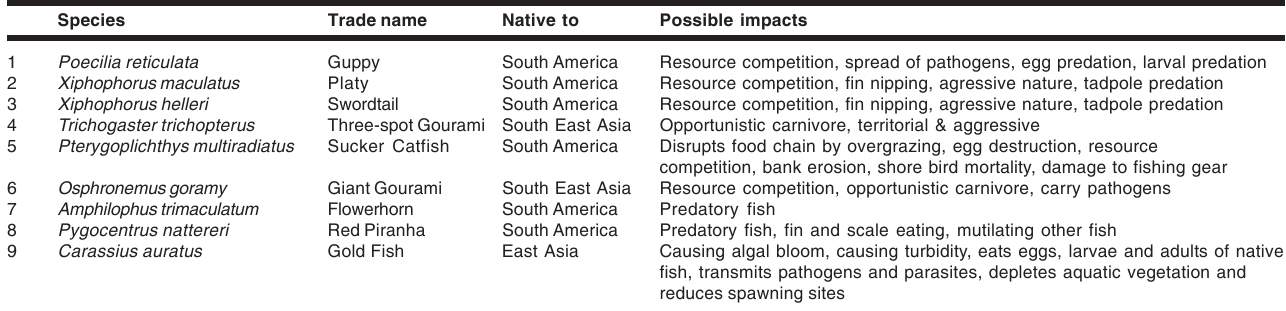
Table 1. Invasive ornamental fishes in Peninsular India and their possible impacts